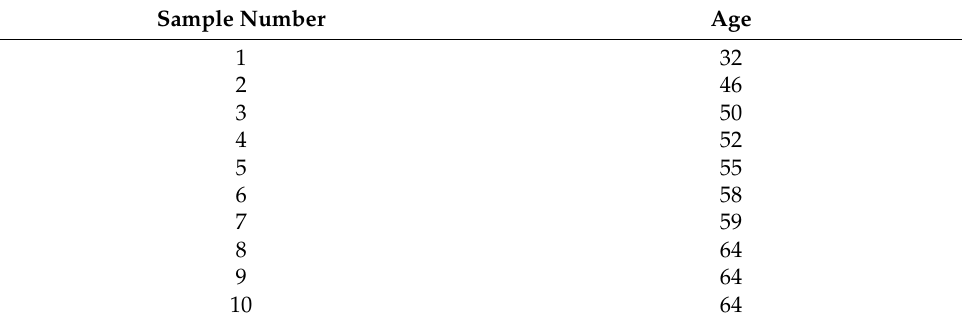
Figure A1. Microphotographs of the human SNc from a non-diseased sample ( A ) and from a PD specimen with α -synuclein (arrows) ( B ) inclusions. Note the pigmented DA neurons free of α synuclein (arrowheads). Scale bar: 100 µm. Table A1. Female specimens included in the non-diseased TMA.